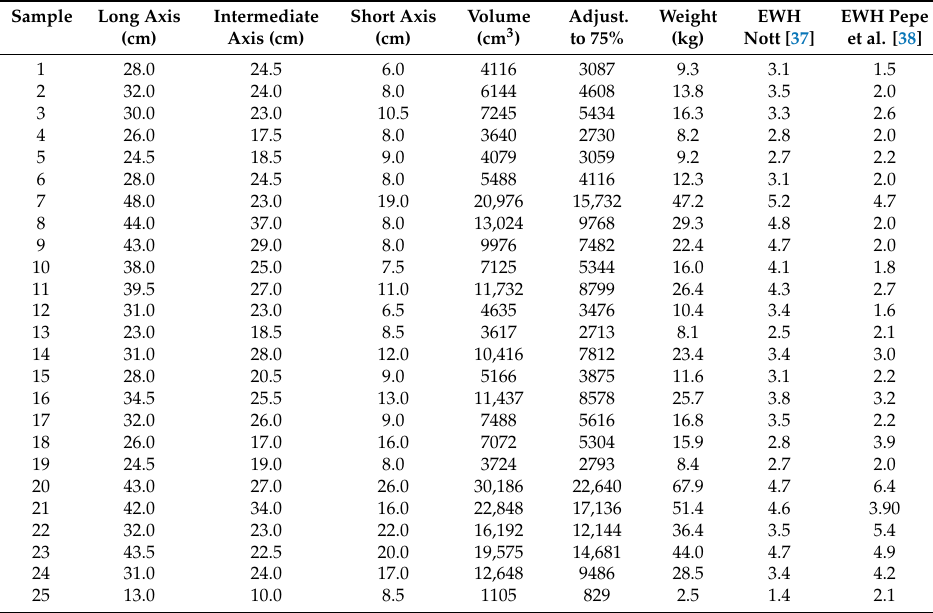
Table 1. Quantification of boulder size, volume, and estimated weight from the modern coastal boulder deposit at site 1 at Prainha, on the southern coast of Santa Maria Island (see Figure 1b). The standard density of basalt at 3.0 gm / cm 3 was applied uniformly in order to calculate wave height for each boulder. EWH: estimated wave height (in meters), calculated according to equations from Nott [37] and Pepe et al. [38]. See the methods Section 3.2. (hydraulic model). Sample Long Axis Intermediate Short Axis Volume Adjust. Weight EWH EWH Pepe (cm) Axis (cm) (cm) (cm 3 ) to 75% (kg) Nott [37] et al. [38]